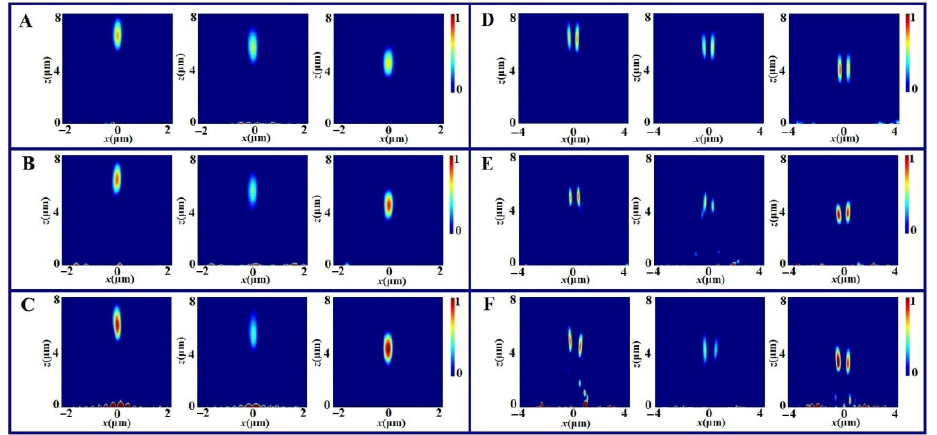
Figure 5. ( A – C ) Focusing of three metalenses with the illuminating wavelength taking 488 nm, 532 nm and 633 nm and the polarization taking RCP; ( D – F ) focusing vortex metalens with the illuminating wavelength taking 488 nm, 532 nm and 633 nm and the polarization taking linearly polarization along the x direction. Where ( A , D ) are for the geometric phase elements consisting of cross nanoholes, ( B , E ) are for the propagation phase elements consisting of L-shaped nanoholes and ( C , F ) are for the resonant phase ones consisting of V-shaped nanoholes.